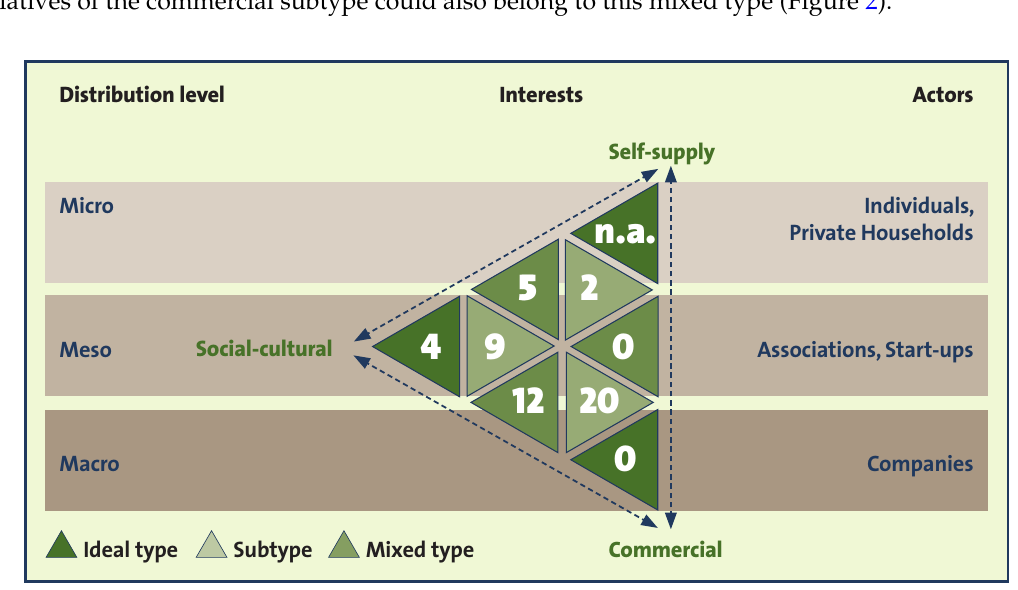
Figure 2. Calculated frequency distribution of urban agriculture types in the sample of German UA initiatives retrieved from Stadtacker.net (n =